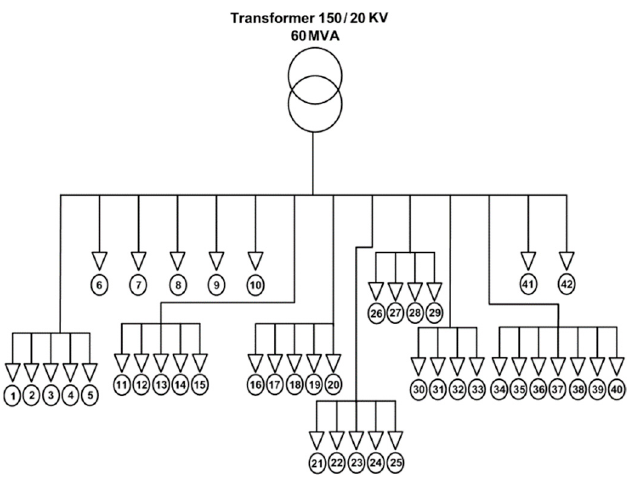
Figure 6. Simplified 20-kV distribution network.